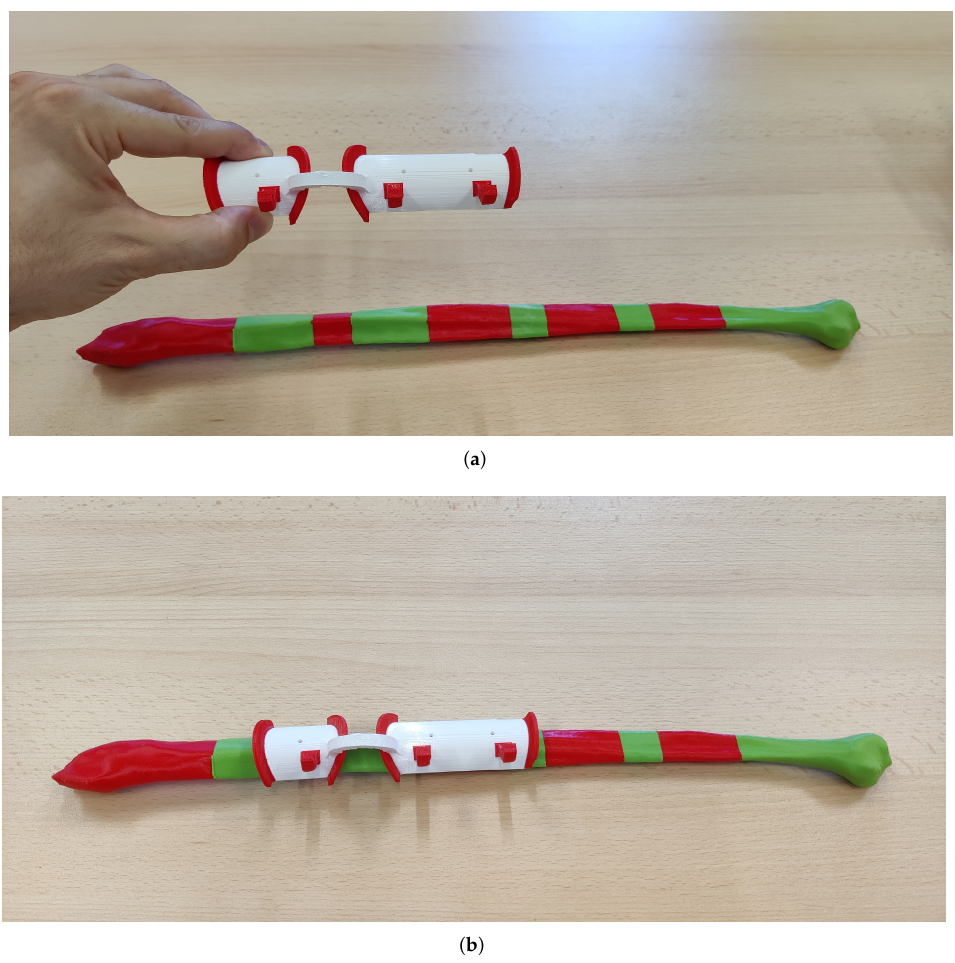
Figure 1. Surgical guide and fibula 3D models. ( a ) 3D models of surgical guide (red and white) and fibula (red and green) before the positioning. ( b ) 3D models positioned as planned for the